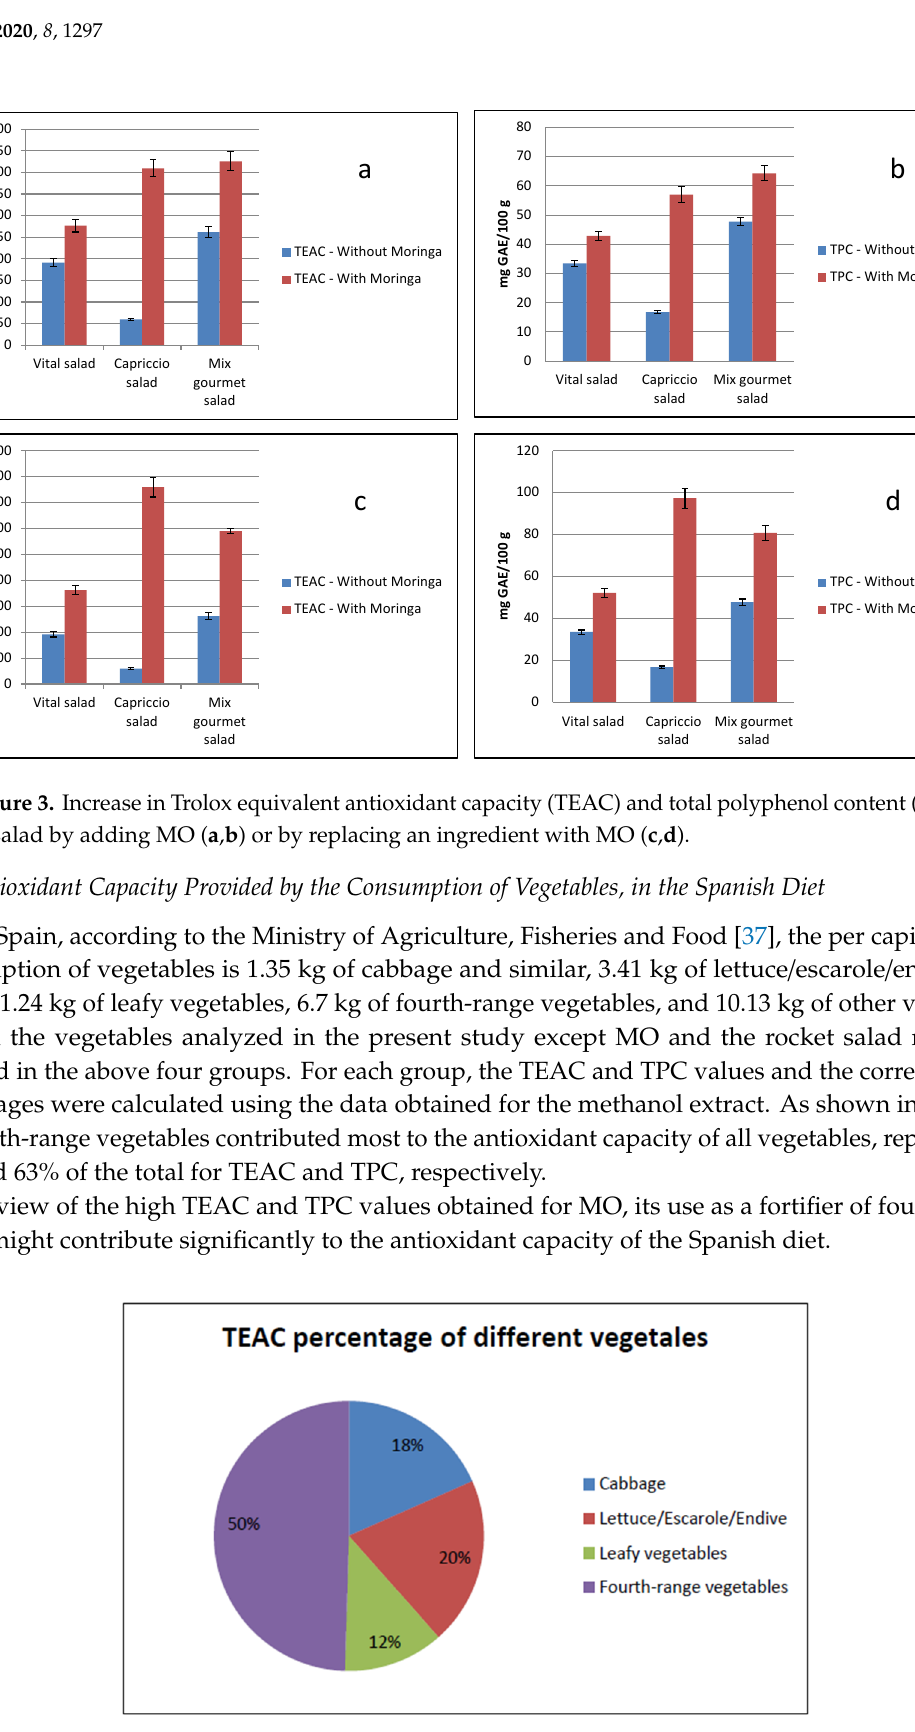
Figure 4. Percentage contribution to TEAC and TPC of the different vegetables consumed in Spain. In view of the high TEAC and TPC values obtained for MO, its use as a fortifier of fourth-range salads might contribute significantly to the antioxidant capacity of the Spanish diet. 5. Conclusions The antioxidant capacity of the moringa leaves grown in Andalusia (Spain) is much higher than that of the other 28 leafy vegetables analyzed. This difference is apparent in all of the extracts considered and with all of the methods employed. Furthermore, the leaves are rich in total phenolic compounds, carotenoids, total flavonoids, and chlorophylls. In consequence, its inclusion as an ingredient in fourth-range (fresh-cut pre-packaged food) would significantly increase the theoretical antioxidant capacity of this commercial product, which currently provides over 50% of the antioxidant capacity of all vegetables consumed in Spain. Author Contributions: Authors made the following contributions: Conceptualization, E.J.G.-H. and B.G.-V.; investigation, J.G.-R. and S.A.-A.; data curation, J.G.-R., V.V., and E.J.G.-H.; writing—original draft preparation, J.G.-R.; writing—review and editing, E.J.G.-H. and B.G.-V.; supervision, E.J.G.-H. All authors have read and agreed to the published version of the manuscript. Funding: The research was partially supported by the Spanish Ministry of Economy and Competitiveness (Proyectos del Plan Nacional 2018, RTI2018-099835-A-I00). Acknowledgments: This paper and the results presented constitute part of the doctoral thesis by Jaime González-Romero carried out within the Nutrition and Food Science Doctoral programme of the University of Granada. Vito Verardo thanks the Spanish Ministry of Economy and Competitiveness (MINECO) for “Ramon y Cajal” contract (RYC-2015-18795). The authors thank the native English translator Glenn Harding for language assistance. Conflicts of Interest: The authors declare they have no conflict of interest.